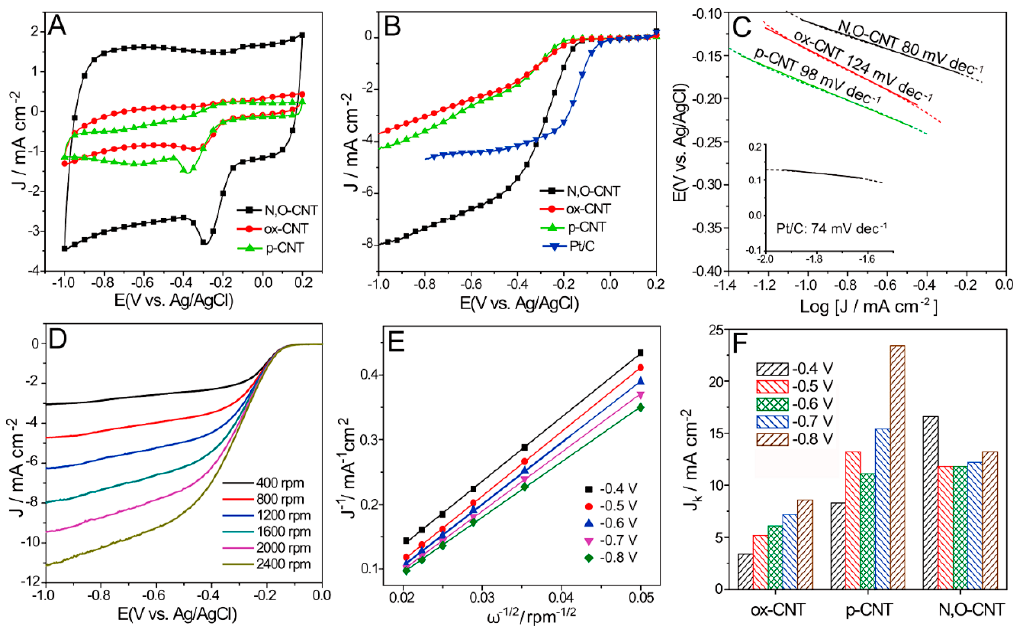
Figure 3. ( A ) CV curves of p-CNT, ox-CNT, and N, O-CNT in O 2 -saturated 0.1 M KOH solution. ( B ) LSVs at a sweep rate of 5 mVs − 1 , and ( C ) Tafel slope obtained from the LSVs of p-CNT, ox-CNT, N, O-CNT, and Pt/C. ( D ) Linear sweep voltammograms (LSVs) of N, O-CNT at different rotating speeds from 400 to 2400 rpm. ( E ) K-L plots of N, O-CNT obtained at different potentials. ( F ) Kinetic limiting current density (J k ) of different catalysts at a potential range from − 0.4 to − 0.8 V.